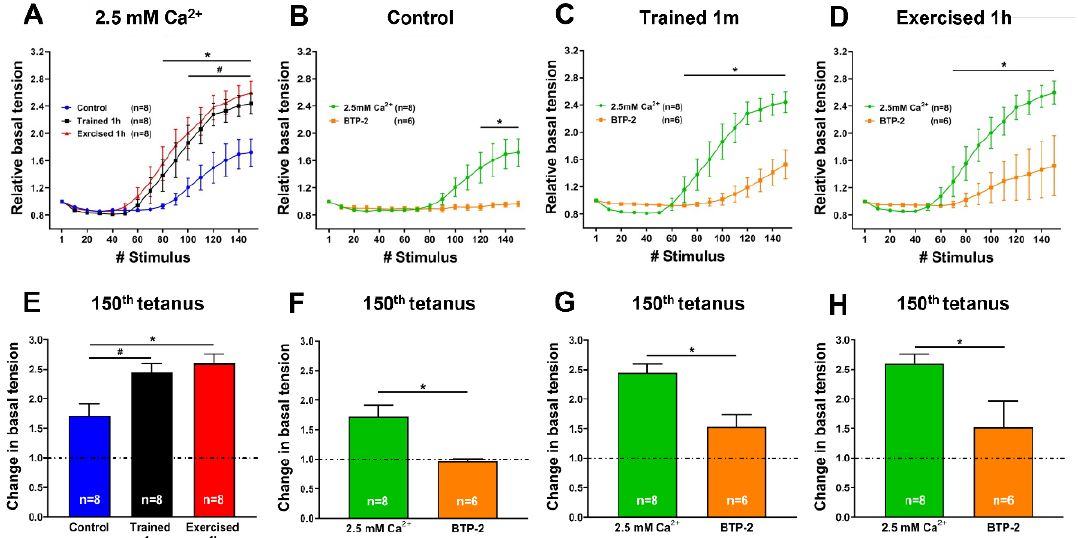
Figure 2. Relative and specific basal tension developed by isolated EDL muscles during an ex-vivo ES protocol: ( A – D ) Relative basal tension during an ex-vivo ES protocol in intact EDL muscles either in presence of 2.5 mM of extracellular Ca 2+ (panel ( A )) or in a solution supplemented with 10 µ M BTP-2 (panels ( B – D )); ( E – H ) specific basal tension recorded at 150th tetanus, either in presence of 2.5 mM extracellular Ca 2+ (panel ( E )) or in a solution supplemented with 10 µ M BTP-2 (panels ( F – H )). Data are shown as mean ± SEM; in panels ( A , E ): * ,# p < 0.05 = * difference between control and exercised-1 h mice; # difference between control and trained-1 m; in panels ( B – D ) and ( F – H ): * p < 0.05 = difference between 2.5 mM Ca 2+ and BTP-2; as evaluated by two-tailed unpaired Student’s t -test). Note, n = number of EDL muscles